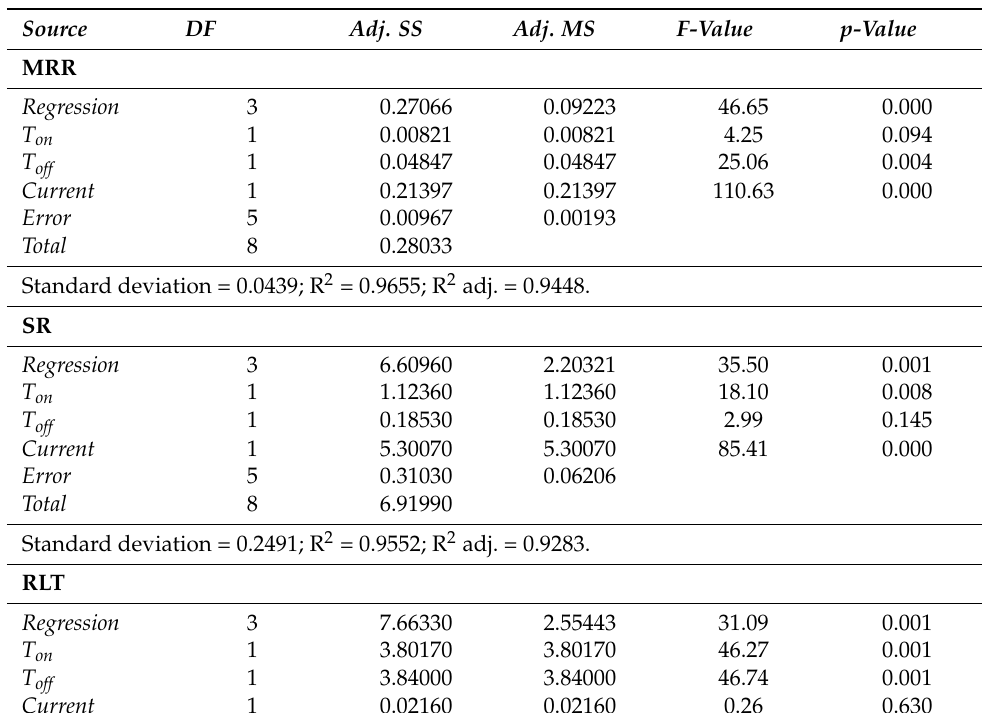
Table 3. Statistical significance of output measures through ANOVA from regression